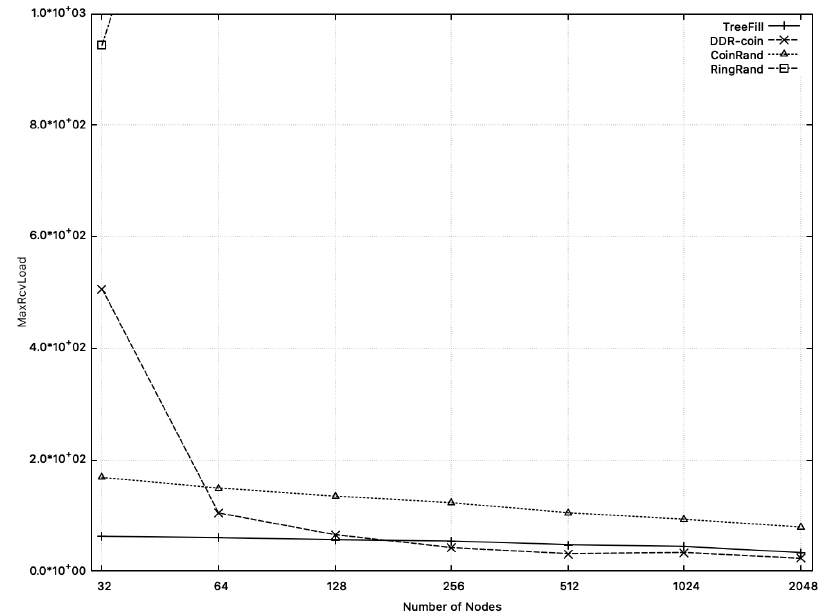
Figure 15. Comparison of MaxRcvLoad of DDR-coin, TreeFill, CoinRand, and RingRand when the number of nodes is 2 i where 5 ≤ i ≤ 8. The number of triggers is w =